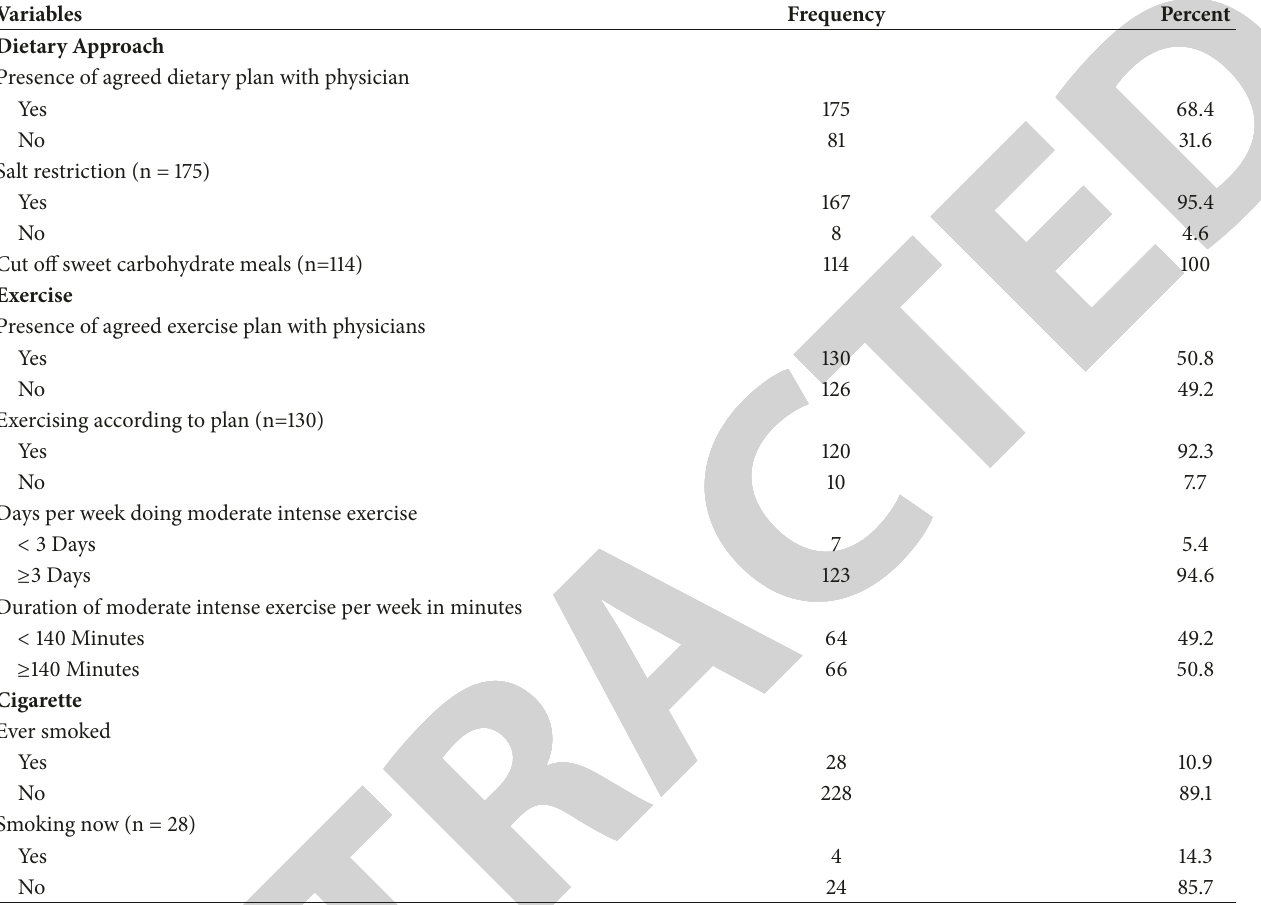
Table 4: Nonpharmacological management approaches used among chronic kidney disease patients attending the renal clinic of Tikur Anbessa Specialized Hospital.